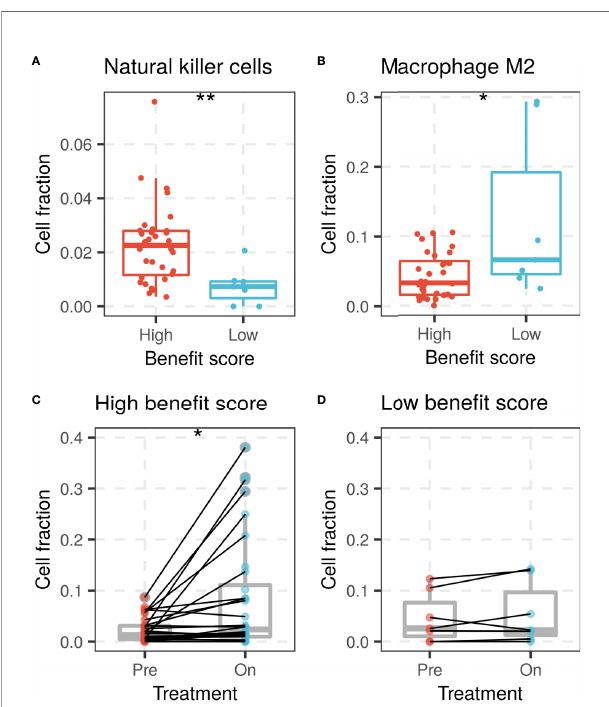
FIGURE 4 | NK cells and macrophage M2 fractions of patients between high and low bene fi t score groups in the Riaz cohort. (A) NK cell fraction of patients grouped by bene fi t score is shown by a box plot at left, while (B) the macrophage M2 fraction is shown on the right side. CD8 T cell fraction change during ICI treatment in (C) high bene fi t score group and (D) low bene fi t score group. (*p < 0.05, **p < 0.01).